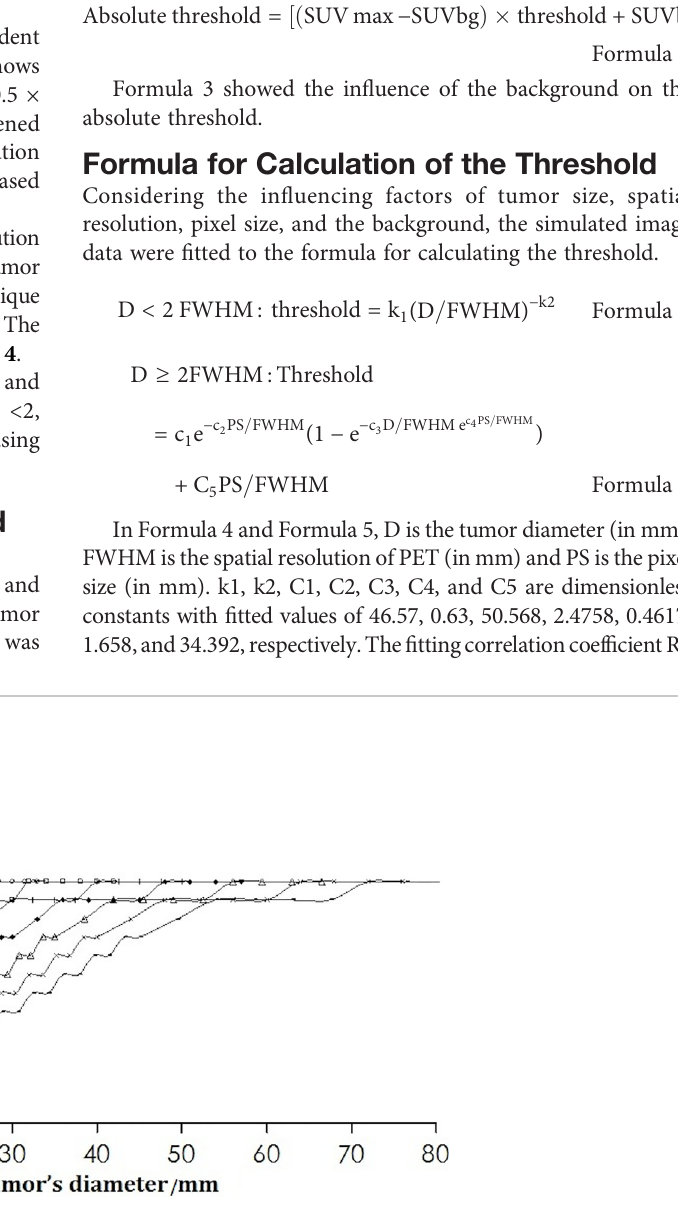
FIGURE 2 | Change in the threshold with tumor diameter. The curves from left to right are for the spatial resolutions from 2 to 9